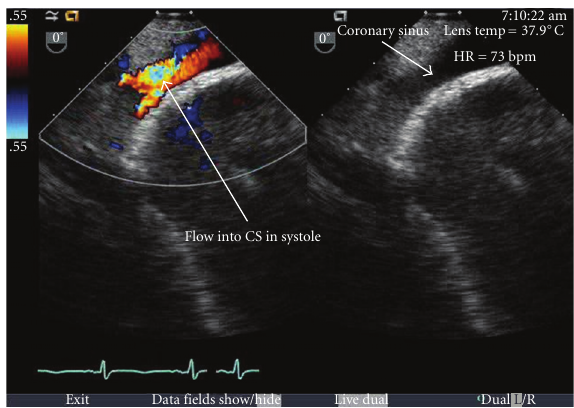
Figure 2: TEE showing doppler signal away from LA. The arrows indicate a dilated coronary sinus.